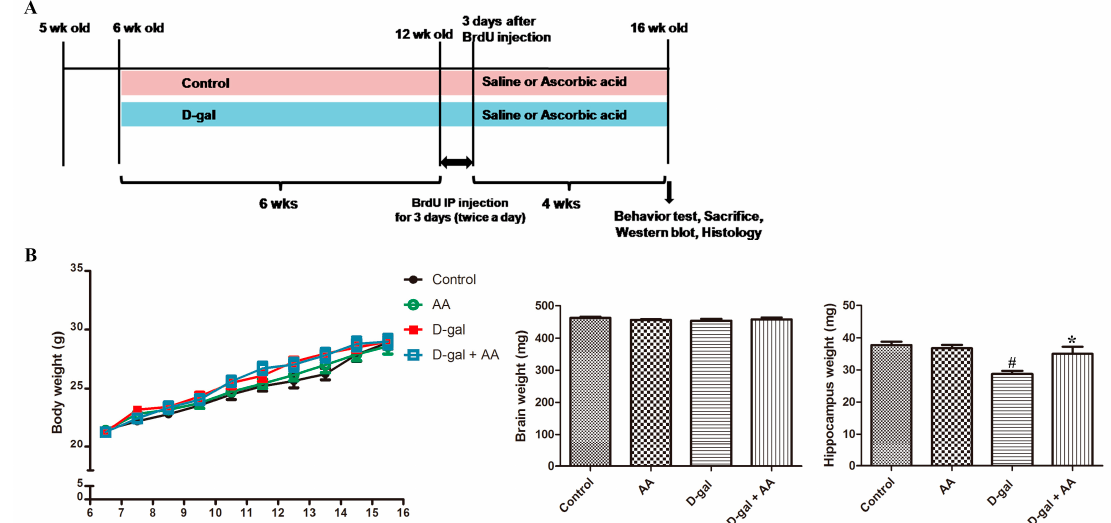
Figure 1. Experimental design ( A ) and changes in body and brain weights ( B ) in control, D-galactose (D-gal), ascorbic acid (150 mg/kg; AA), and ascorbic acid (150 mg/kg)-fed D-gal (D-gal + AA) groups ( n = 27 per group). 5-bromo-2 ′ -deoxyuridine (BrdU) was intraperitoneally (IP) injected. # p < 0.05, indicating a significant difference between control and D-gal groups. * p < 0.05, indicating a significant difference between D-gal and D-gal + AA groups. Data are presented as means ± SEM. wk: week.